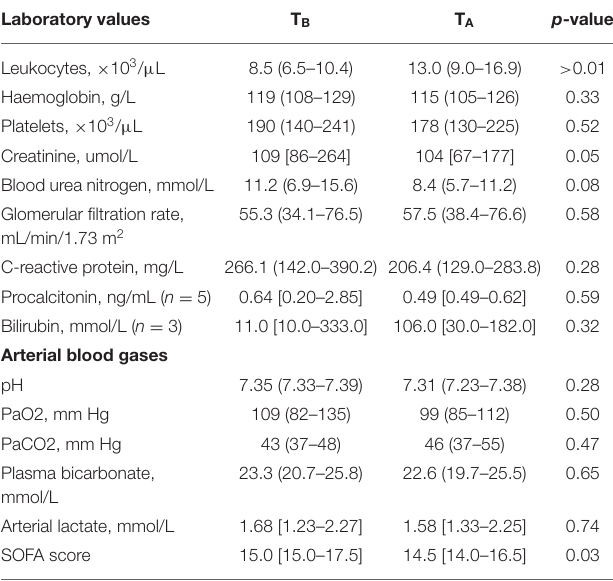
TABLE 2 | Before and after comparisons for all patients.